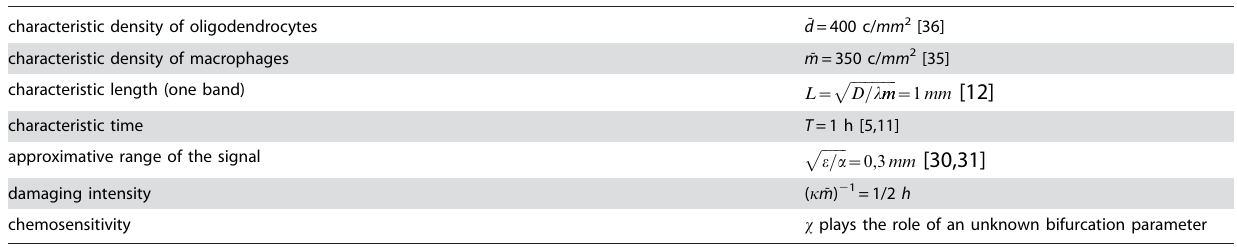
Table 2. Numerical data on concentric demyelination used as mean values for the reduced parameters in numerical simulations. .. ... .... ... ... .... ... ... .... ... ... .... ... ... .... ... ... .... ... ... .... ... ... .... ... ... .... ... ... .... ... ... .... ... ... .... ... ... .... ... ... .... ... ... . characteristic density of oligodendrocytes characteristic density of macrophages